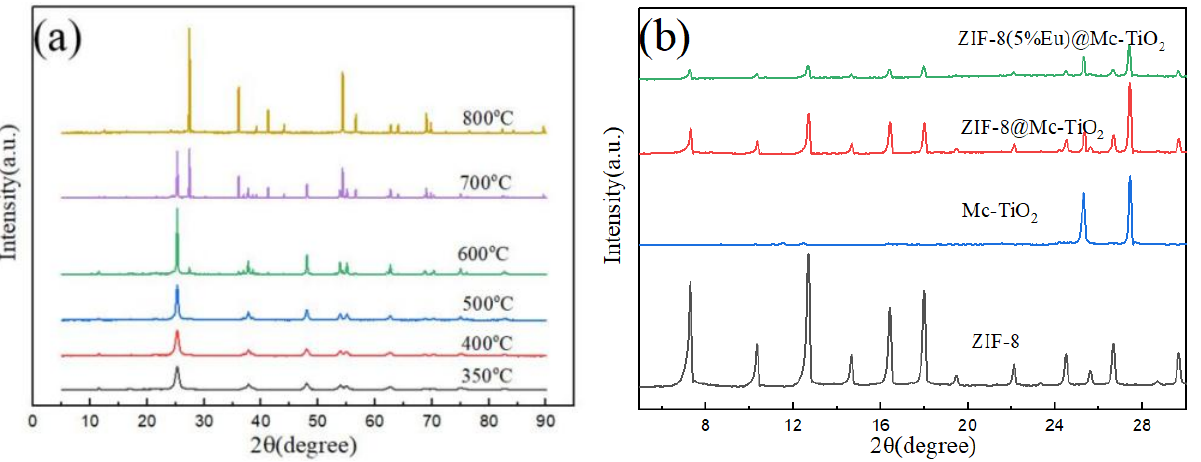
Figure 1. ( a ). XRD patterns of TiO 2 at different temperatures and ( b ). XRD patterns of ZIF-8(Eu)@Mc-TiO 2 , ZIF-8@Mc-TiO 2 , Figure 1. ( a ) XRD patterns of TiO 2 at different temperatures and ( b ) XRD patterns of ZIF-8(Eu)@Mc-TiO 2 , ZIF-8@Mc-TiO 2 , Mc-TiO 2 , ZIF-8. Mc-TiO 2 ,